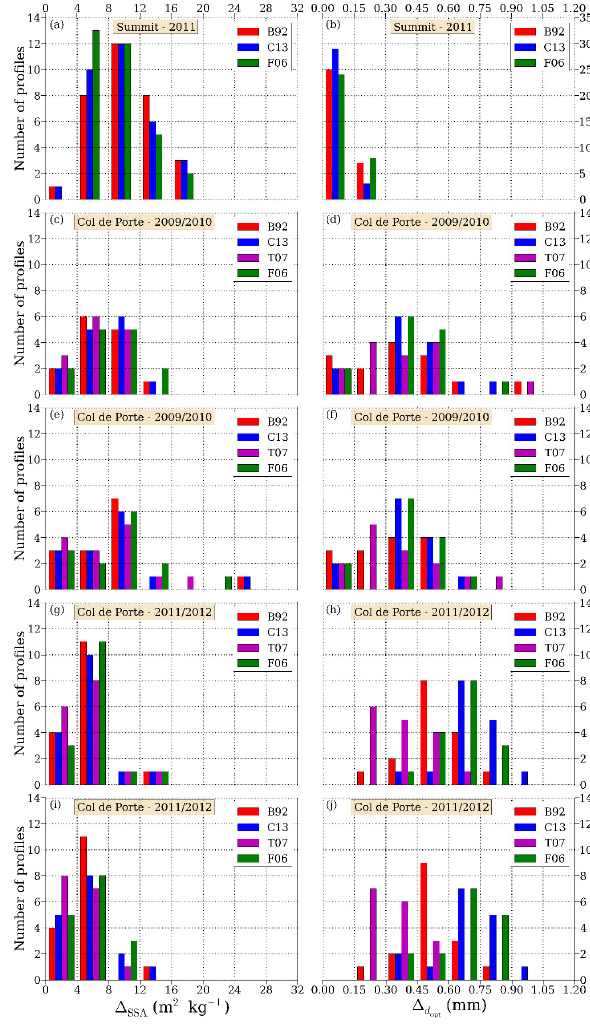
Fig. 14. Comparison between simulations and observations in terms of 1 SSA (left column) and 1 d (right column). (a, b) 1 values opt computed for Summit. (c, d) 1 values computed for Col de Porte during the winter of 2009/2010. (e, f) 1 values computed for Col de Porte during the winter of 2009/2010, in which simulations were stretched vertically in order to match the measured snow height. (g, h) Same as (c, d) for the winter of 2011/2012. (i, j) Same as (e, f) for the winter of